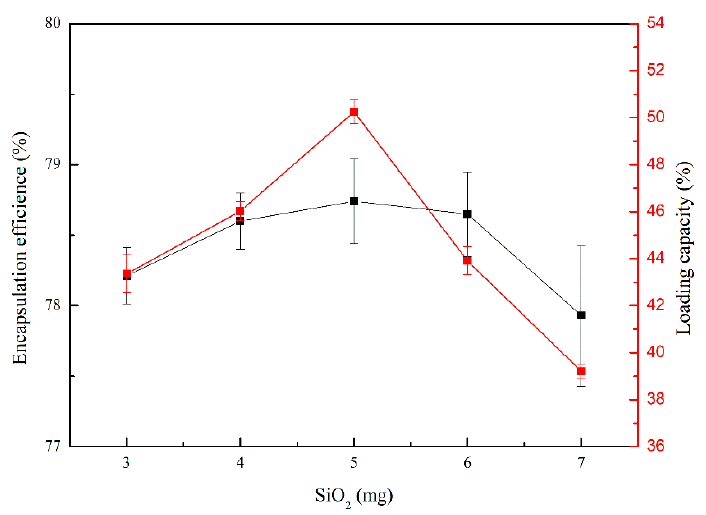
Figure 5. Determination of the encapsulation efficiency and loading capacity of aminated mesoporous SiO 2 nanoparticles adsorbed by Newcastle disease virus inactivation solution.